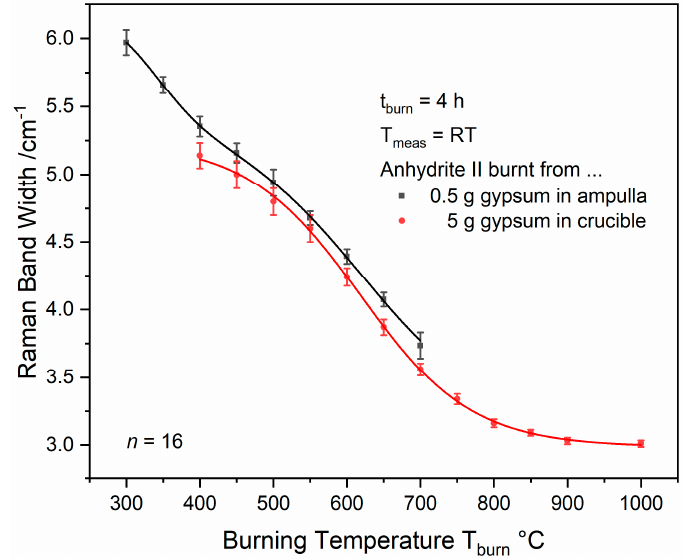
Figure A2. Band widths of the ν 1 Raman mode of anhydrite II as a function of burning temperature. While the points are the data shown in Figure 18, the lines represent sigmoidal functions fitted to this data.